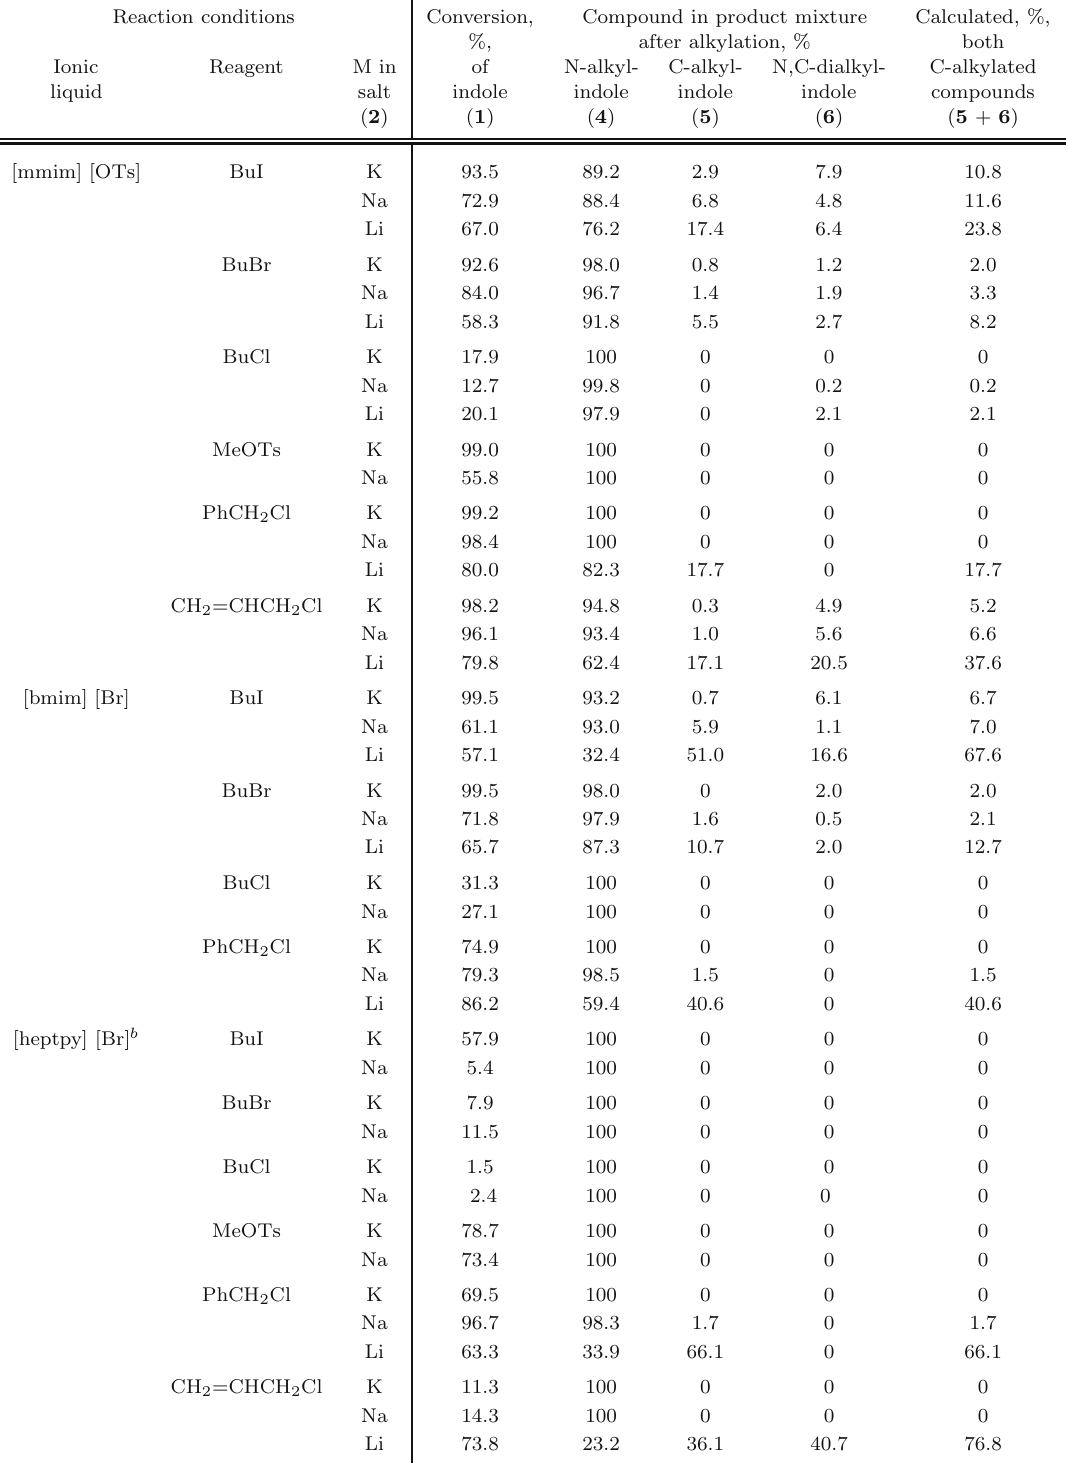
Table 2 Distribution of isomers in the alkylation reactions of indole salts in ionic liquids a